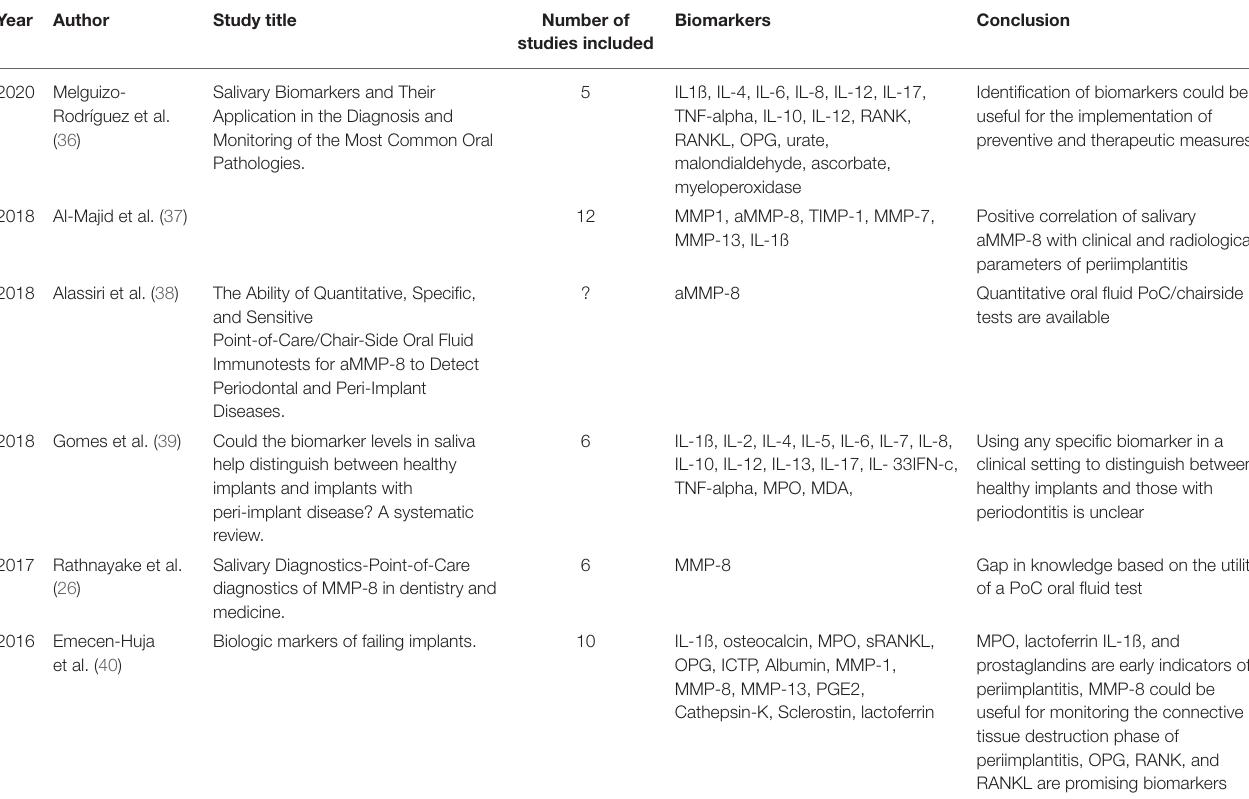
TABLE 1 | Reviews 2014–2020 for salivary biomarkers and